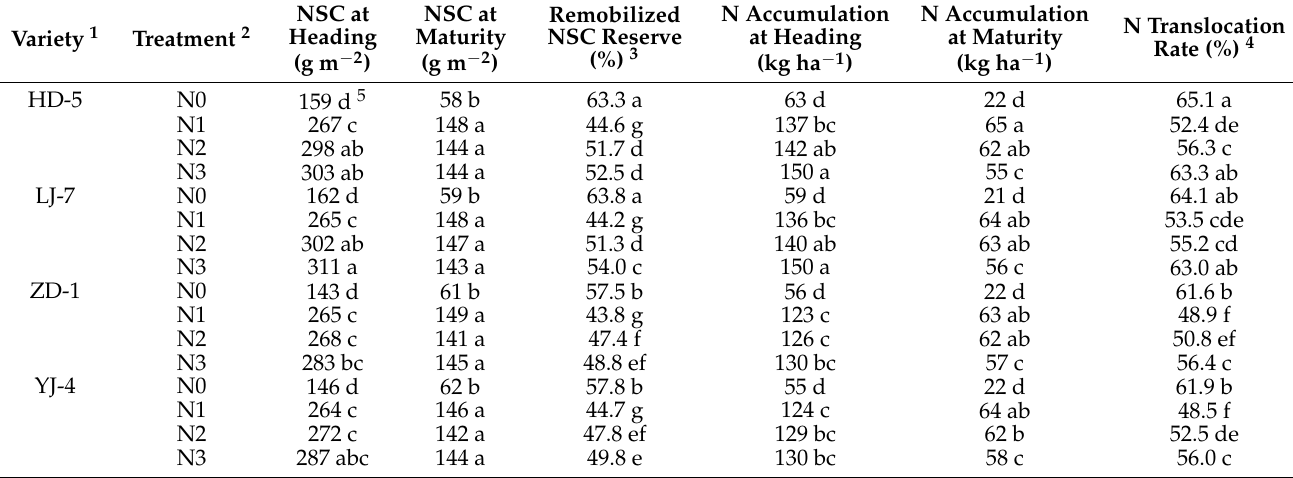
Table 6. Nitrogen (N) uptake and NUE of rice under various N managements.